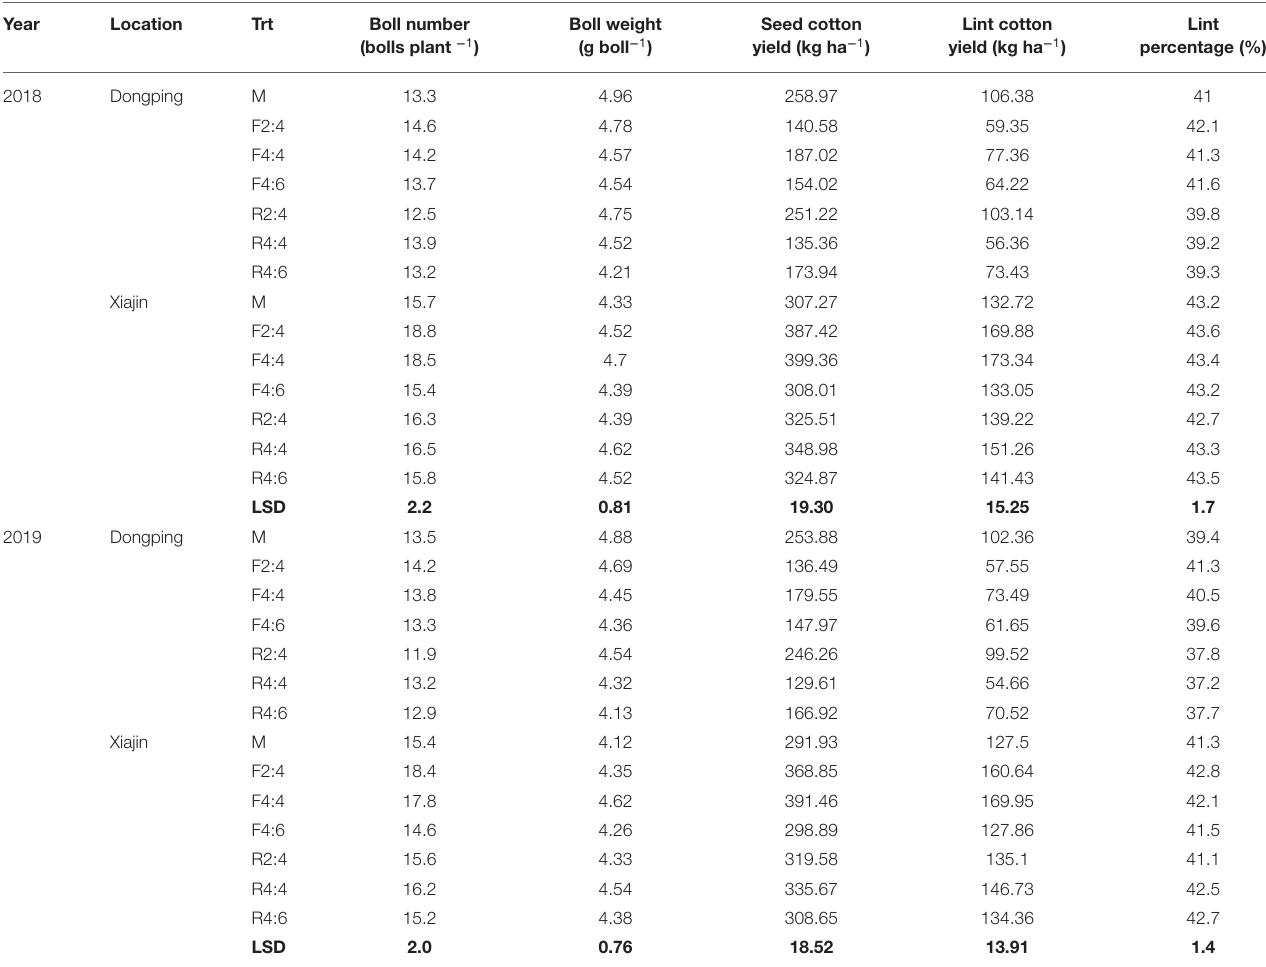
TABLE 2 | From 2018 to 2019, cotton yield and yield components (Dongping and